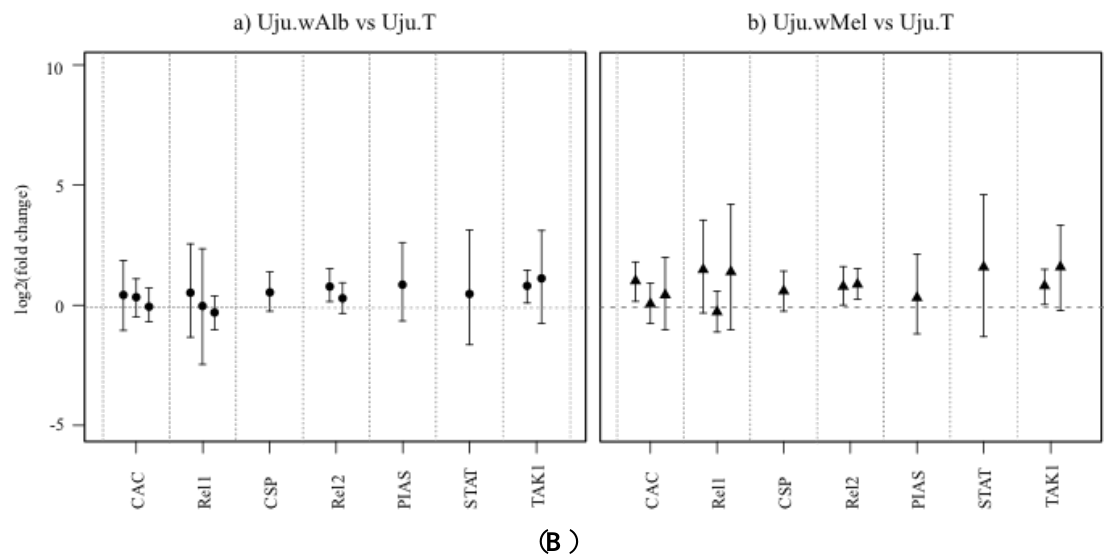
Figure 2. ( A ) Ratio of Wolbachia genome copies to Ae. albopictus genome copies detected in Uju. w Alb and Uju. w Mel adult lines. Genome copies were determined by absolute quantification using a standard curve of plasmid DNA containing the genes of interest. Results are from 4–5 biological replicates of pools containing three females; ( B ) Immune gene transcription in Ae. albopictus lines Uju. w Alb and Uju. w Mel compared to Uju.T. Points represent means of 3–5 biological replicates and error bars denote Bayesian 95% credible intervals. Each bar within a gene category represents an independent experiment.